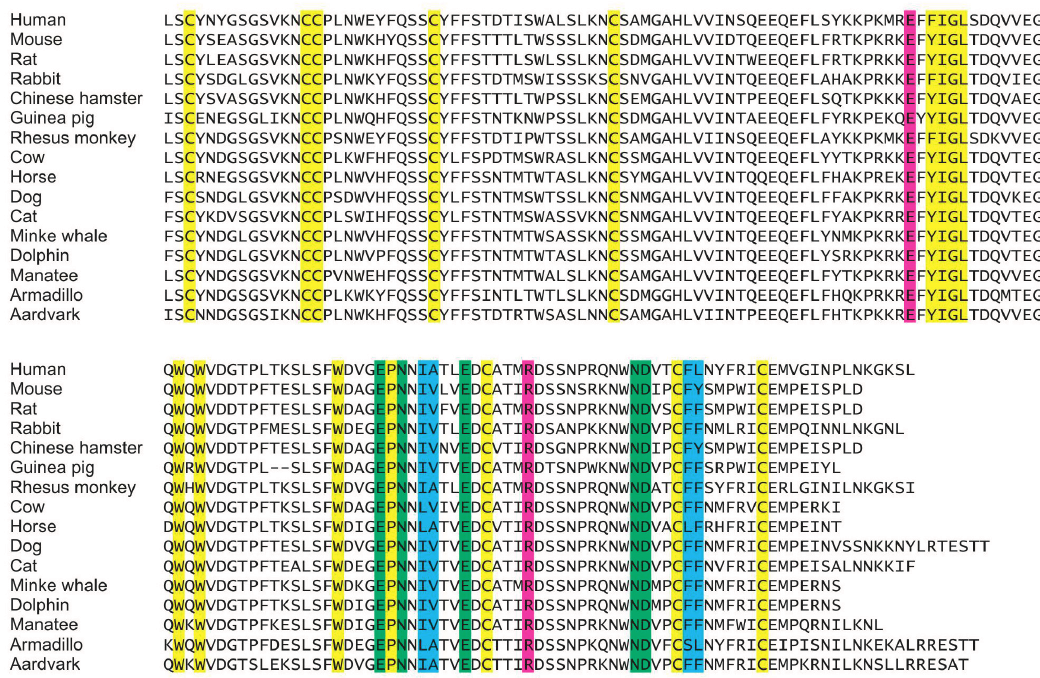
Figure 6. Sequence alignment and conservation of key residues in the CRD of mincle across species. A selection of the 62 sequences of mincle orthologs spanning a range of species is shown. Some of the key conserved framework residues common to C-type CRDs are highlighted in yellow, while the residues involved in binding are indicated as green at the primary binding site for the first residue of glucose in trehalose, magenta at the secondary binding site for the second glucose residue in trehalose and blue at the hydrophobic groove that is proposed to form a binding site for acyl groups attached to the 6-OH groups of trehalose. In all 62 sequences, there is complete conservation of the residues that form the primary and secondary binding sites as well as conservation of the hydrophobic character of the side chains that make up the hydrophobic groove in cow mincle. Based on the analysis of mouse mincle presented here, in combination with previous work on the human and cow proteins, these findings suggest that the binding properties of mincle are likely to be conserved across these